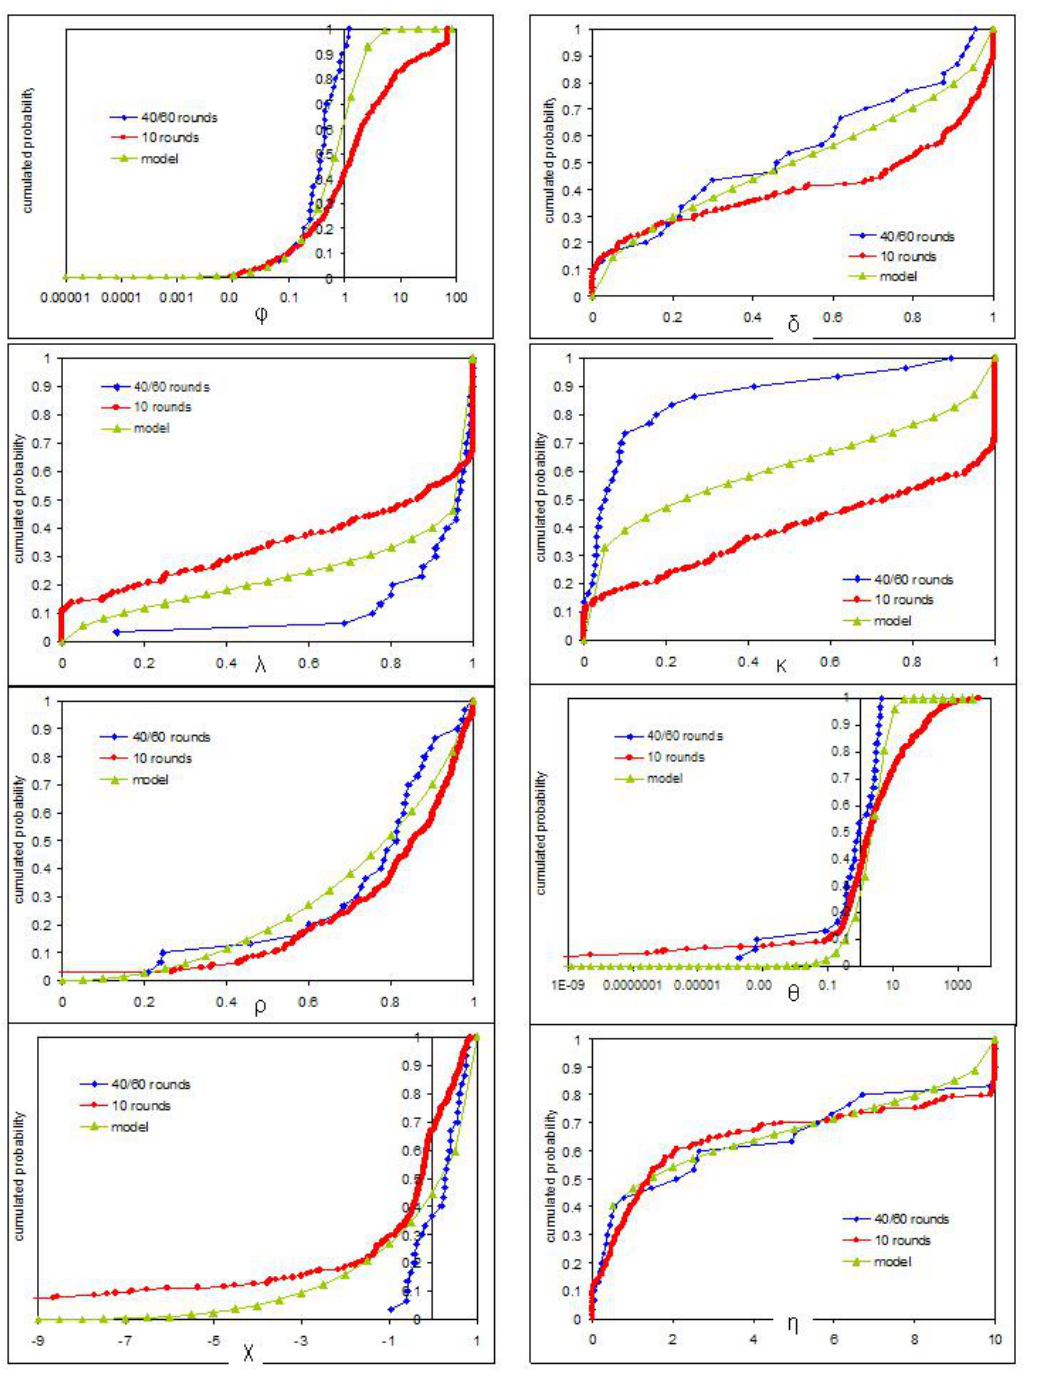
Fig. 6 . Cumulated distribution of the estimated parameters for the two data sets. The parameters are defined in Table